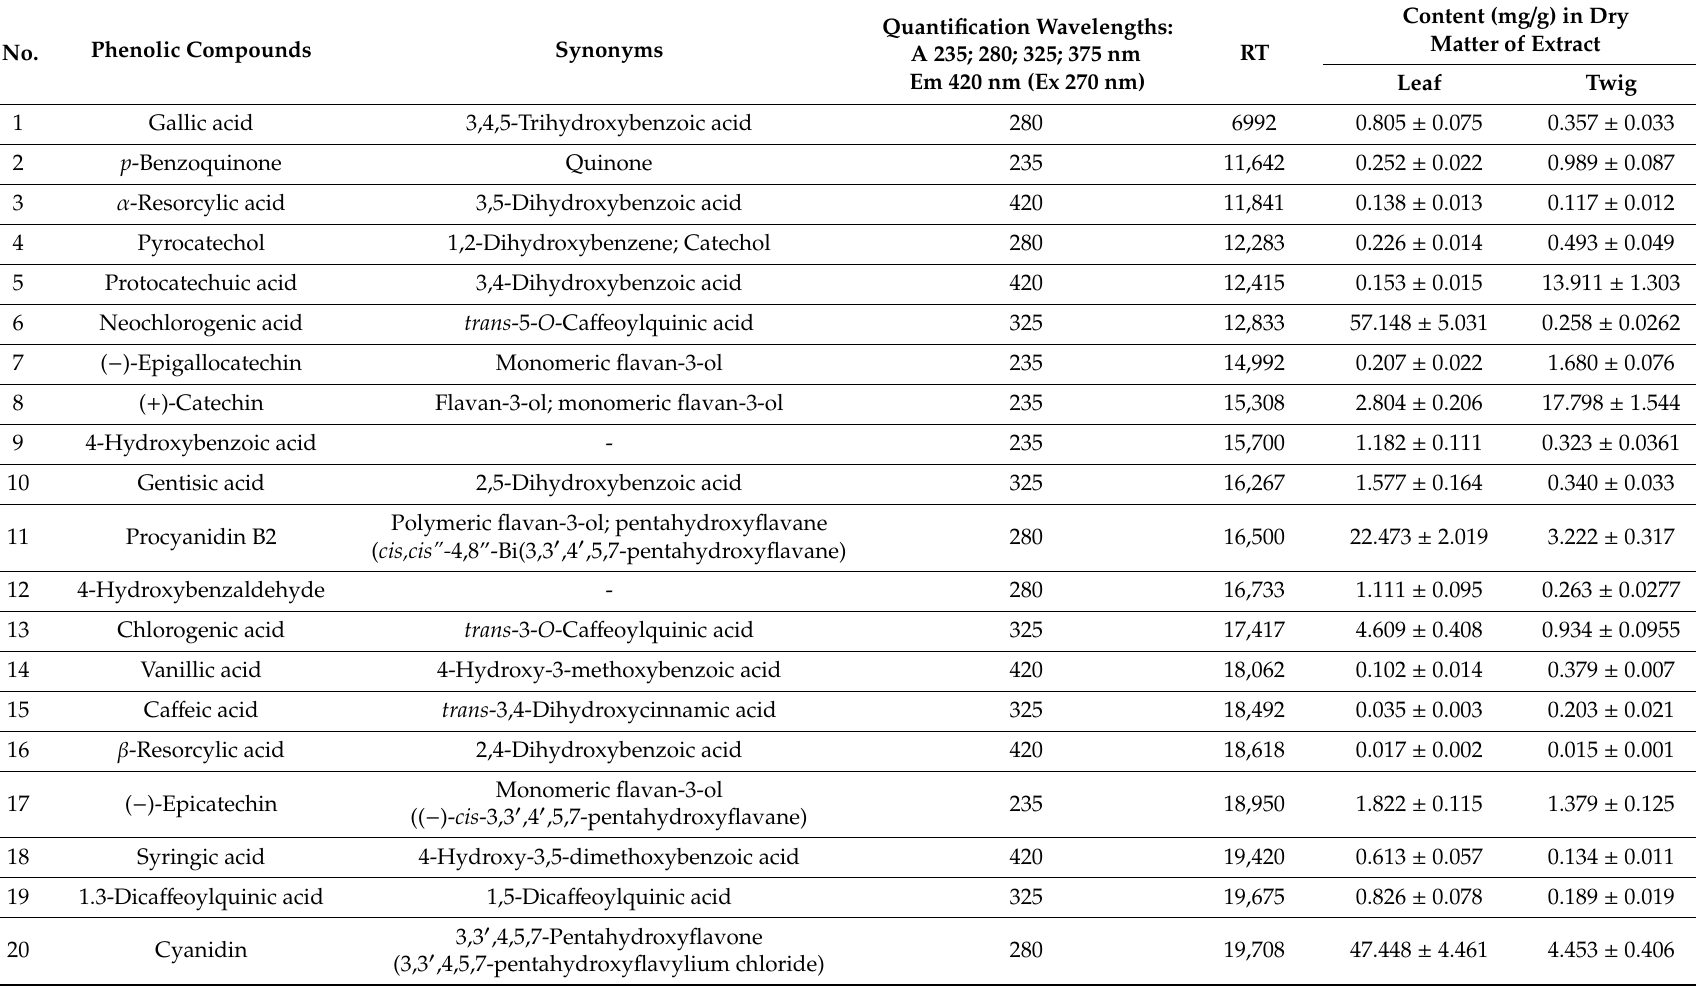
Table 1. Content of phenolic compounds detected using HPLC technique in dried extracts of R. canina leaves and twigs. RT—retention time. Values presented as mean ± SD from 3